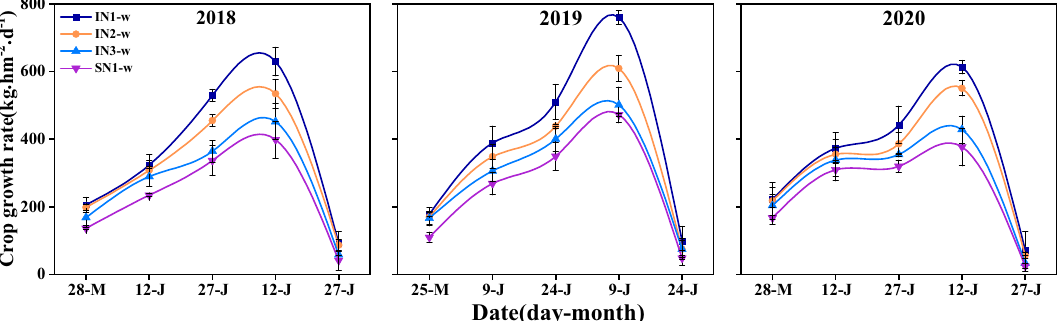
Figure 2. Crop growth rate of wheat in sole and intercropping systems with different N management practices in 2018–2020. I, intercropping, S, sole cropping. For intercropping system, N 1 , N 2 , and N 3 represent N-fertilizer applied at 51, 72, and 93 kg N ha −1 as first top-dressing plus 63, 42, and 21 kg N ha −1 at third top- dressing, respectively. For sole wheat, N 1 represents N-fertilizer applied at 108 kg N ha −1 as base fertilizer plus 72 kg N ha −1 at top-dressing. Plant sampling time is 15 day intervals before wheat harvest and 20 day intervals after wheat harvest. Error bars indicates standard error of the means ( n =